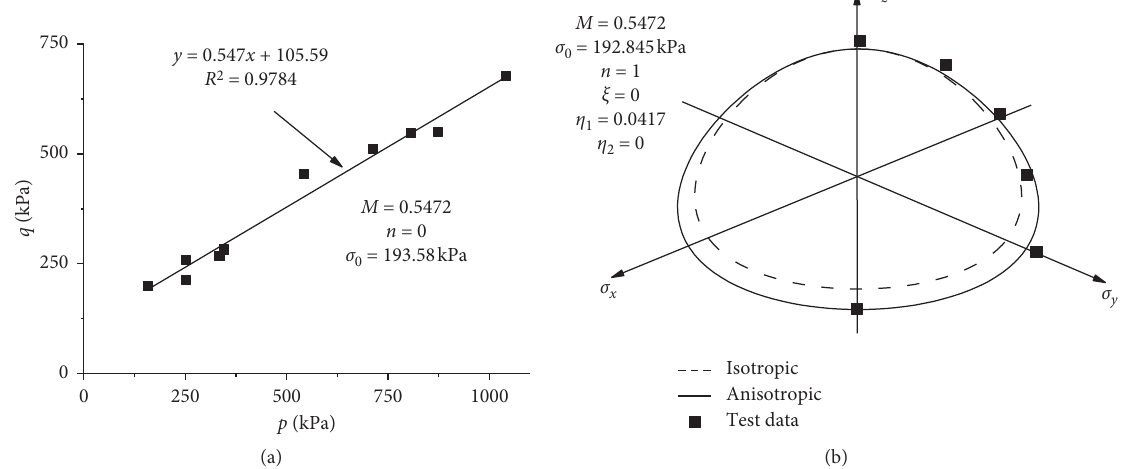
Figure 5: Illustration on calibrating the parameters M